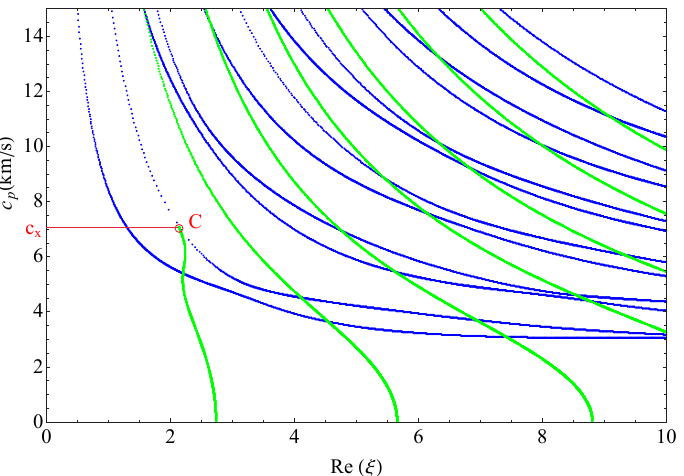
Figure 16. The projection of 3D phase velocity curves, blue branches for purely real solutions, and green for